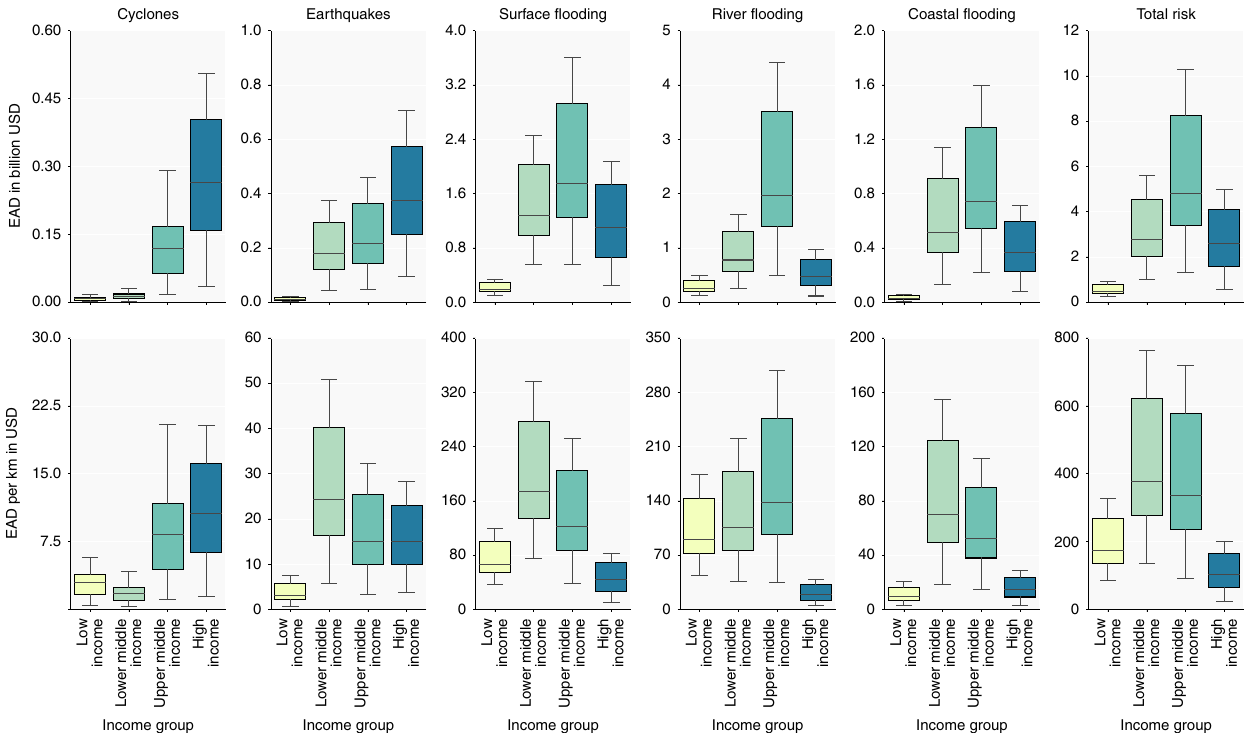
Fig. 4 Expected annual damages per hazard. The upper row of boxplots presents the absolute EAD for each individual hazard and, in the right-most boxplot, the total multi-hazard EAD. The lower row of boxplots presents the EAD per kilometer of infrastructure for each individual hazard and, in the right-most boxplot, the total multi-hazard EAD per kilometer. The lower and upper whiskers represent, respectively, the lowest 25% of the calculated EAD ’ s and the highest 25% of the calculated EAD ’ s for each income